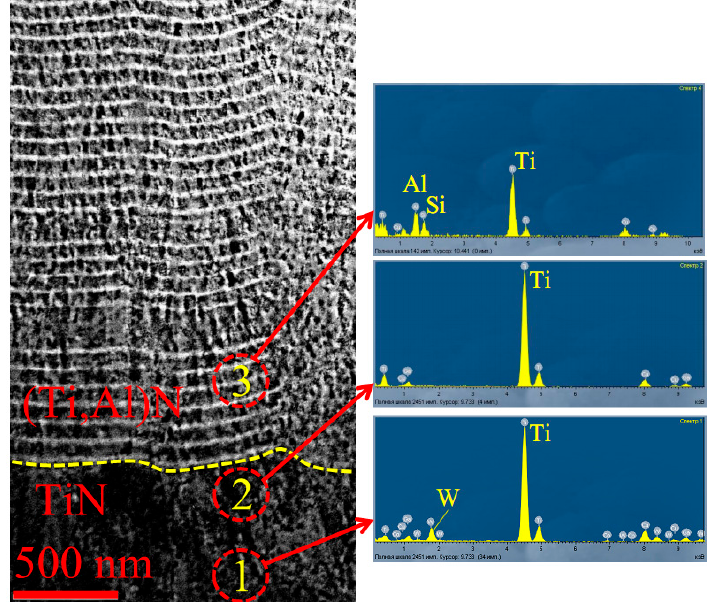
Figure 10. Analysis of the elemental compositions of the transition and wear-resistant layers of the coating. ( 1 ) Area adjacent to the substrate, ( 2 ) area of the transition layer on the border with the wear-resistant layer, ( 3 ) area of the wear-resistant layer on the border with the transition layer, and ( 4 ) area in the central part of the wear-resistant layer (at S4).